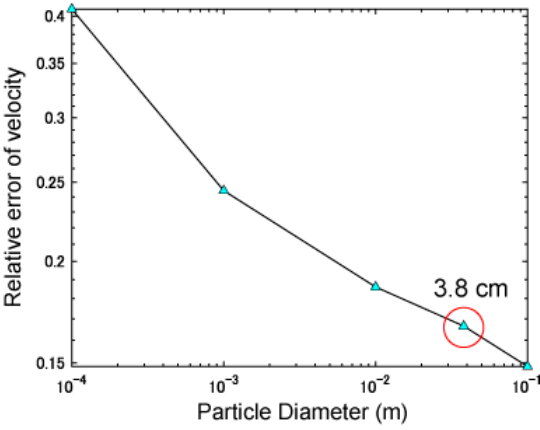
Figure 11. The relative error of velocity on the δ s and δ 2 plane for particle diameters ( a ) d = 10 cm, ( b ) d = 3.8 cm, ( c ) d = 1 cm, ( d ) d = 1 mm, and ( e ) d = 0.1 mm. The white circles show the minimum error position in each plane. The number in each plane is the minimum relative error value.